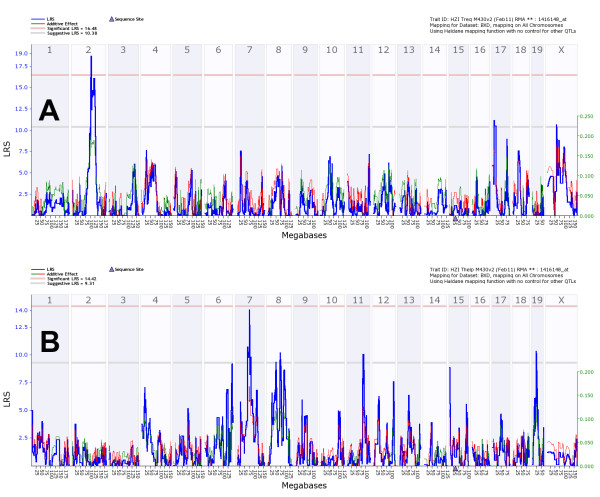
Genome wide eQTL mapping of Laptm4b transcript in Treg and Th cells. (A) eQTL map for Laptm4b (probeset 1416148_at in Tregs and (B) in Th, respectively. See figure 3 for explanation of labels.